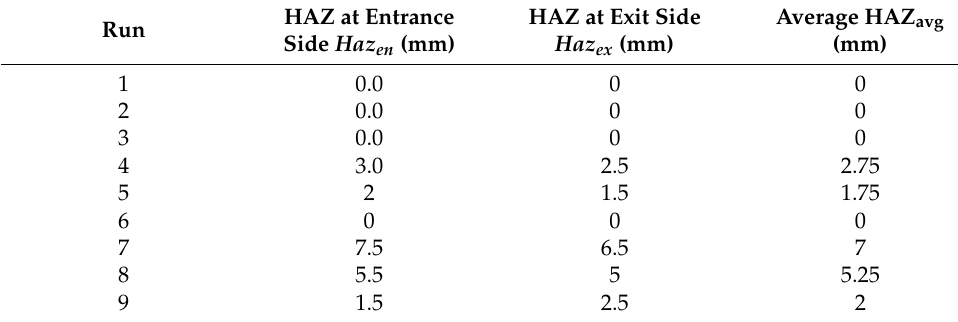
Table A4. Measured data and quality calculation results for HAZ.